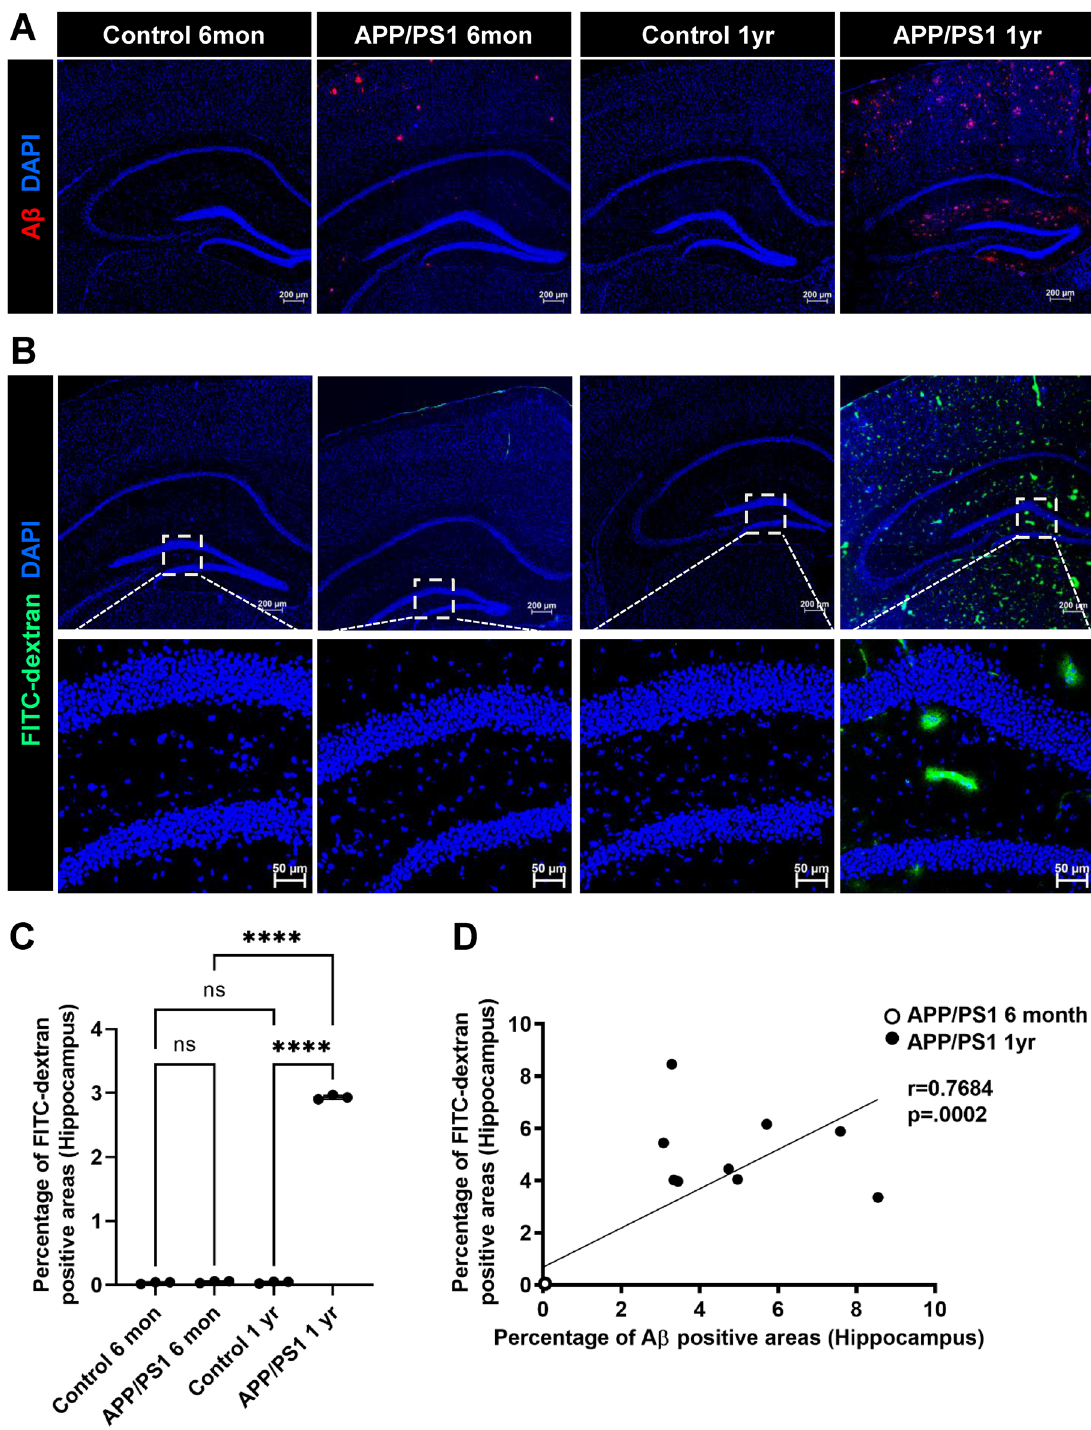
Figure 2. Blood–brain barrier leakiness and Aβ deposition in the hippocampus of APP/PS1 female mice. Control female age-matched and APP/PS1 female mice were analyzed at ages of 6 months and 1 year old for amyloid plaque deposition by staining with antibodies against Aβ (red) and BBB permeability assessed by FITC-dextran leakage (green). Low-magnification representative images of coronal sections of the hippocampus for Aβ ( A ) and of FITC-dextran leak ( B ). The ROI is outlined with a white box and subsequent images are given at higher magnification of tissue corresponding to the ROIs for controls and transgenic mice. Nuclei were counterstained using DAPI. Experiments were repeated at least three times with similar results. Increased BBB leak was observed in the 1 year old APP/PS1 female mice. Scale bars, 200 μm and 50 μm respectively. ( C ) Quantification of FITC-dextran leakage in the hippocampus of the above groups. Data are represented as means and SD for three biological replicates and analyzed by one-way ANOVA followed by Tukey’s multiple comparisons test. **** p = 0.0001, ns non-significant. ( D ) Correlation of Aβ deposition and FITC-dextran leakage from 6 months and 1 year old APP/PS1 female mice. Increased FITC-dextran leak was correlated with age-dependent Aβ accumulation. Correlation coefficients and p value are indicated. r Pearson’s coefficient, p